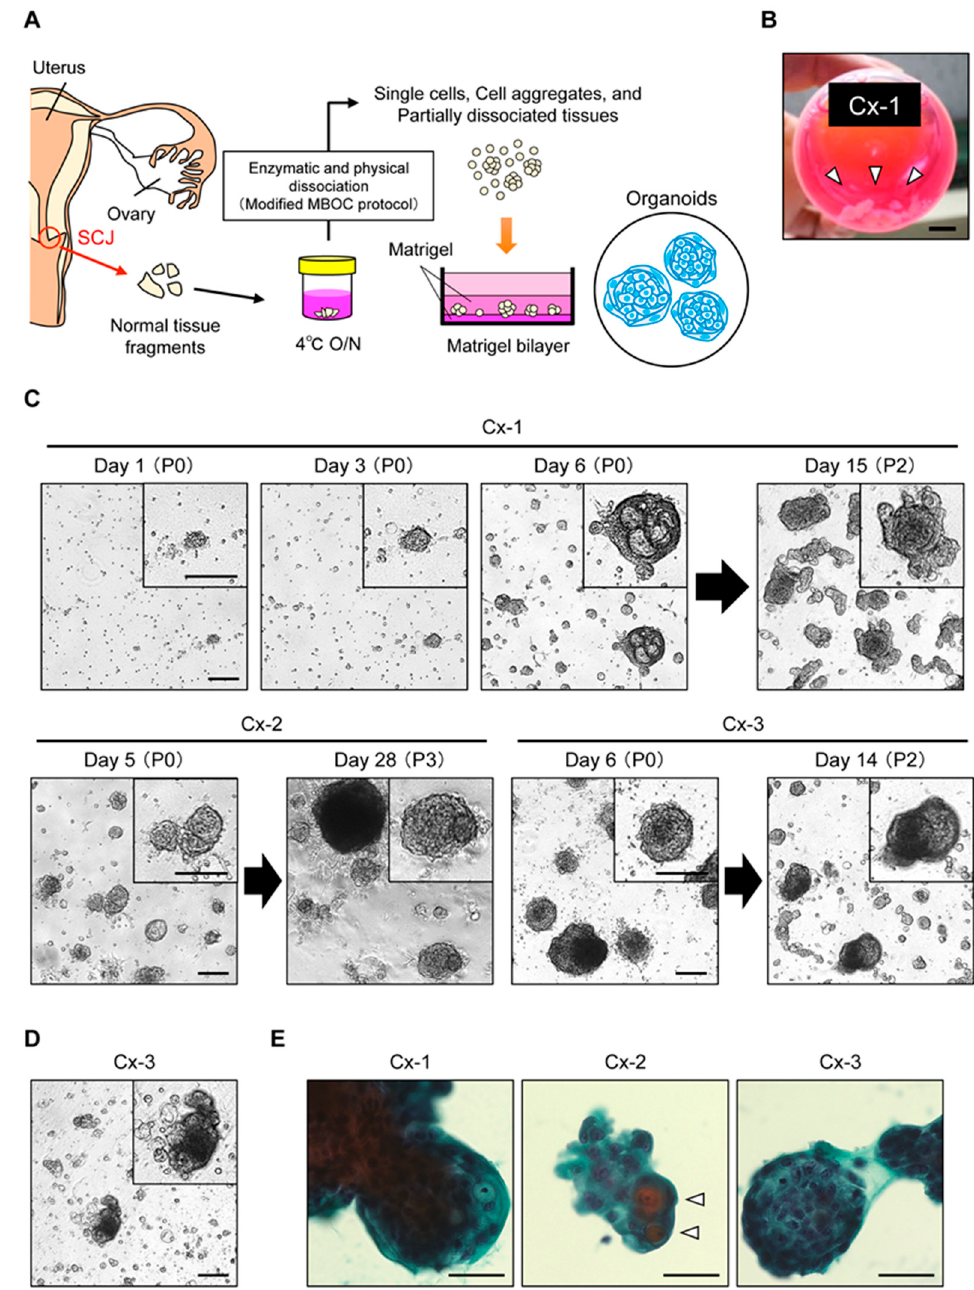
Figure 1. Organoid culture of normal cervical cells derived from the squamocolumnar junction (SCJ) region. ( A ) Schematic presentation of procedures for the establishment of SCJ-derived organoids. A modified Matrigel bilayer organoid culture (MBOC) protocol was used (see Materials and Methods). ( B ) Tissue samples collected from the cervical SCJ. A scale bar indicates 10 mm. White arrowheads depict tissue fragments. ( C ) Phase-contrast images of organoids. Upper panel, representative time-lapse images of SCJ-derived organoids (Cx-1) in the bright field (passage P0 and P2) at 1–6 days and 15 days. Lower panel: representative bright field images of the other SCJ-derived organoids (Cx-2 and Cx-3). Note dense homogeneous cell aggregates in the upper left area of the panel for Cx-2 at day 28. Insets show magnified images of organoids. Scale bars indicate 200 µ m. ( D ) Propagation of organoids after cryopreservation. A phase contrast image of Cx-3 organoids at day 14 (passage P1) after thawing is shown. ( E ) Papanicolaou staining of SCJ-derived organoids. Open arrowheads show superficial squamous cells. Scale bars indicate 50 µ m.